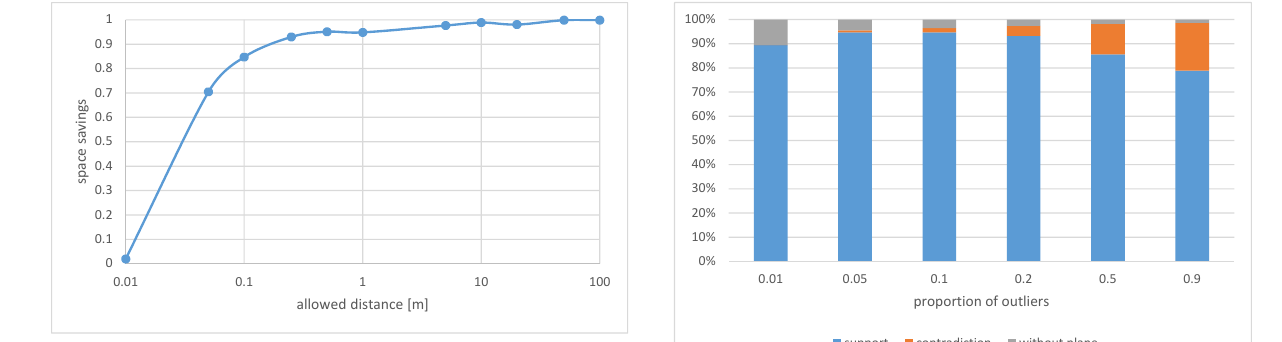
Figure 6. Resulting space savings for different allowed point-to- plane distances.